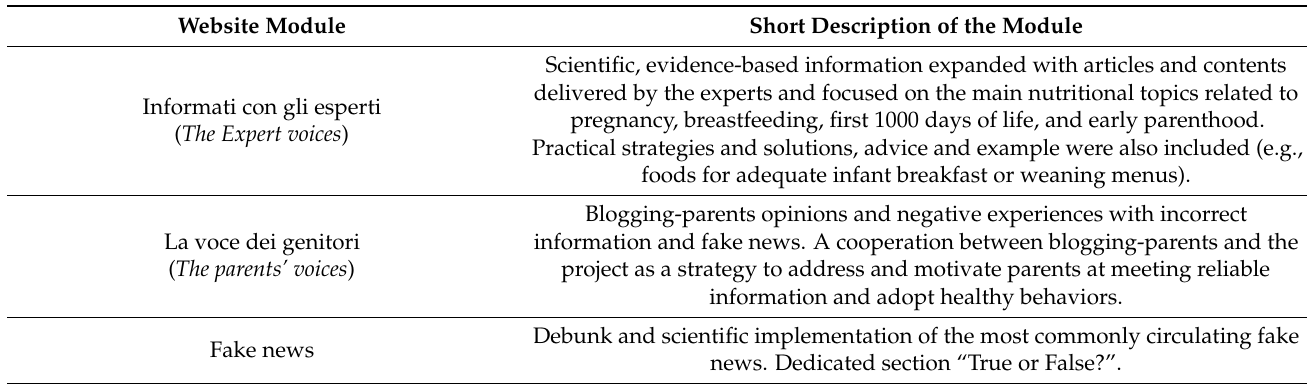
Table 1. Overview of the website content and short description of the